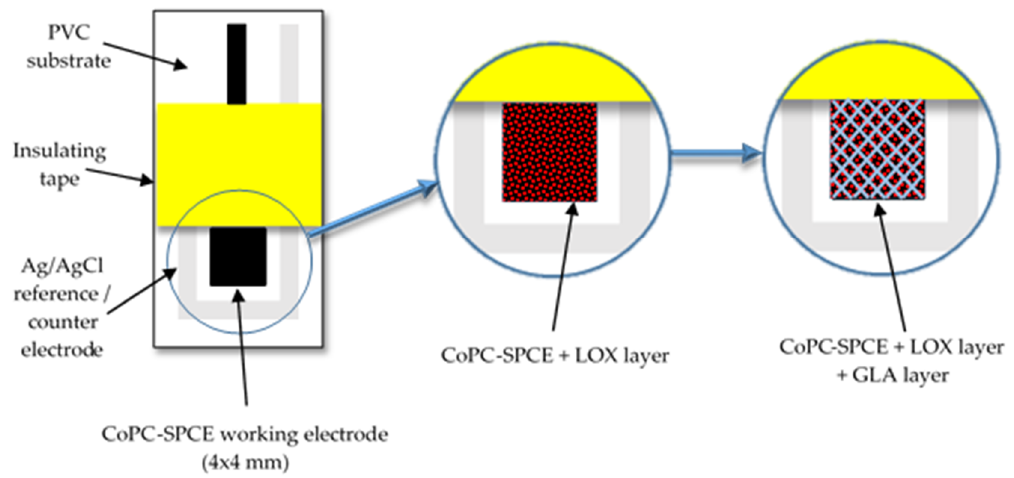
Figure 2. Schematic showing the sequential deposition of the enzyme and cross-linking agent onto Table 3. Schematic diagram of the amperometric fatty acid biosensor design and the sequence of reactions involved in its operation; SPCE = screen-printed carbon electrode; LOX = lipoxygenase; GLA = glutaraldehyde.